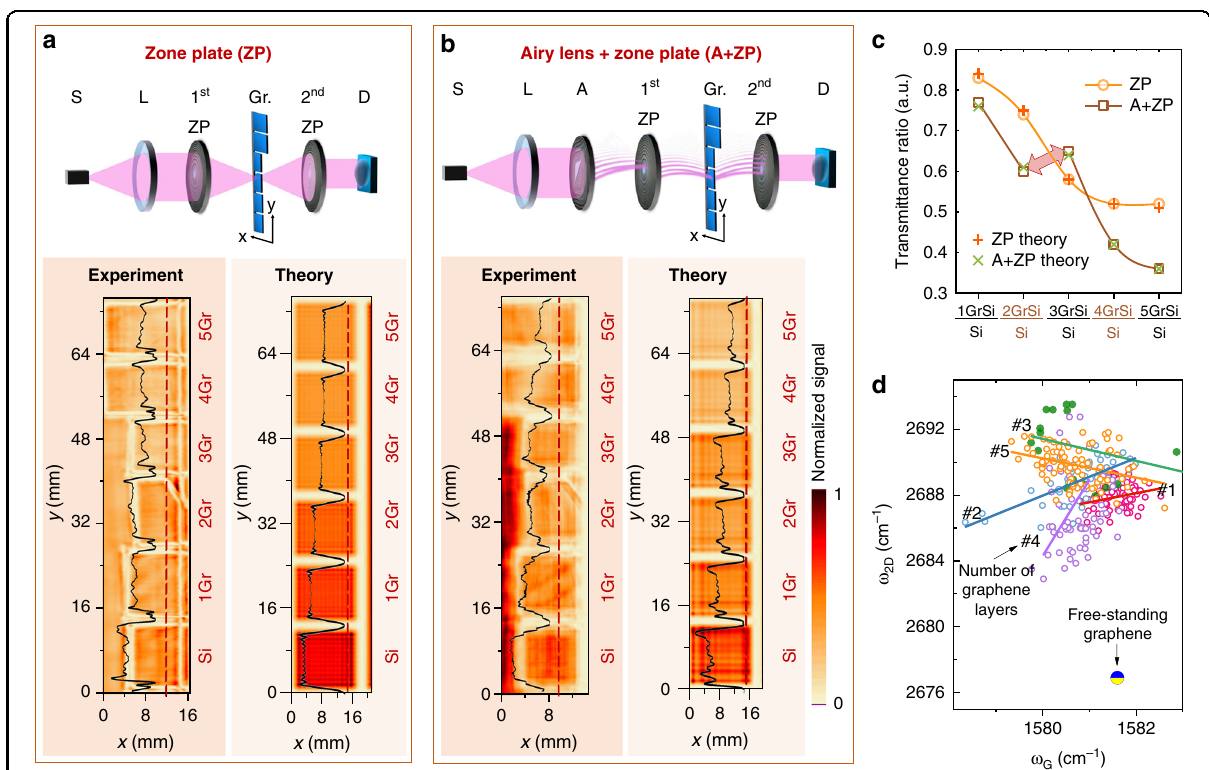
Fig. 5 Imaging using nonparaxial THz structured light illumination. The sample under test consists of different numbers of graphene layers denoted on the graph. The THz illumination is produced using different con fi gurations of lenses: ( a ) two zone plates and ( b ) an Airy phase mask combined with two-zone plates. Setups are depicted at the top of segments ( a ) and ( b ). Gr denotes the imaged sample with graphene layers. Experimentally obtained and numerically calculated imaging results are presented below. The color bars are normalized to the maximum signal. The dashed red line indicates the position of cross-sections of the recorded and calculated intensities given in the left bottom corner. Transmittance ratio of all samples for two different con fi gurations of lenses ( c ). Correlation between Raman 2D and G peak positions for 1 – 5 graphene layers ( d ). Blue/ yellow point marks free-standing